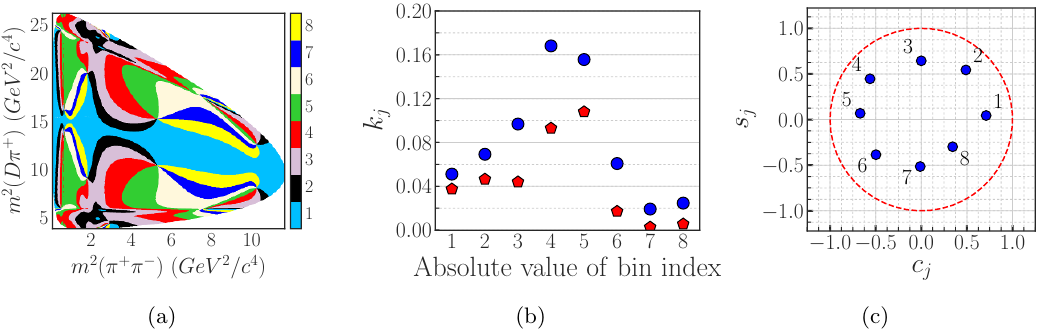
Figure 2 . Dalitz plot distribution of the B 0 low 3 GeV =c 2 for m ( (cid:25) + (cid:25) (cid:0) ) > 1 : 6 GeV =c 2 (b), and m ( (cid:25) + (cid:25) (cid:0) ) distribution below 1 : 6 GeV =c 2 for (cid:0) (cid:1) m D 0 (cid:25) + > 3 GeV =c 2 (c). The distributions are obtained with the B 0 plitude model described in appendix A. The dashed and dot-dashed regions on the Dalitz plot correspond to the distributions on the subplots (b) and (c), respectively.